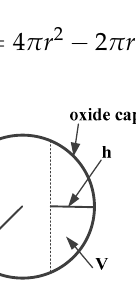
Figure 2. Model of oxide deposition on the aluminum particle surface.